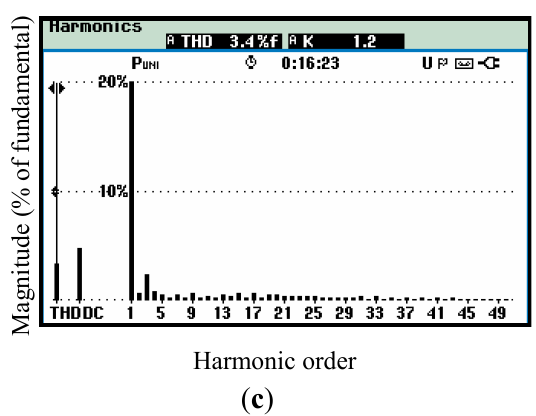
Table 3. Measured efficiency of the BSS-FBC prototype ( U